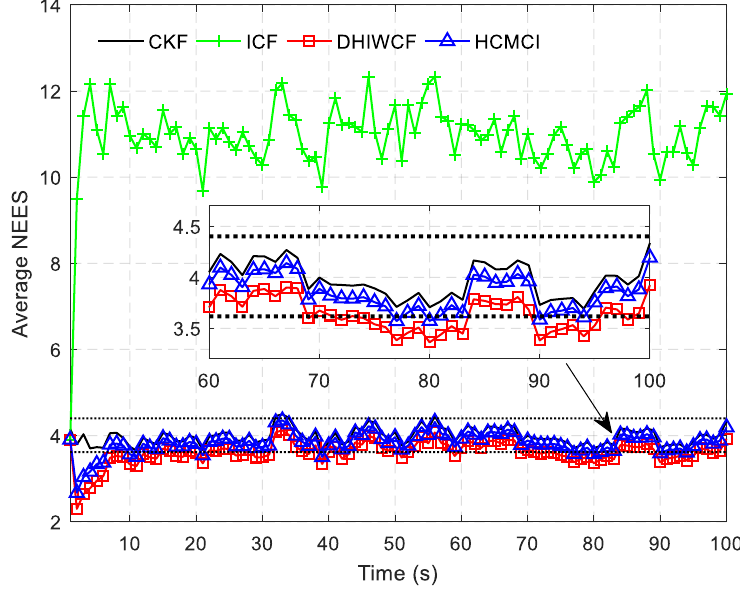
Figure 10. The averaged NEES of the compared algorithms.